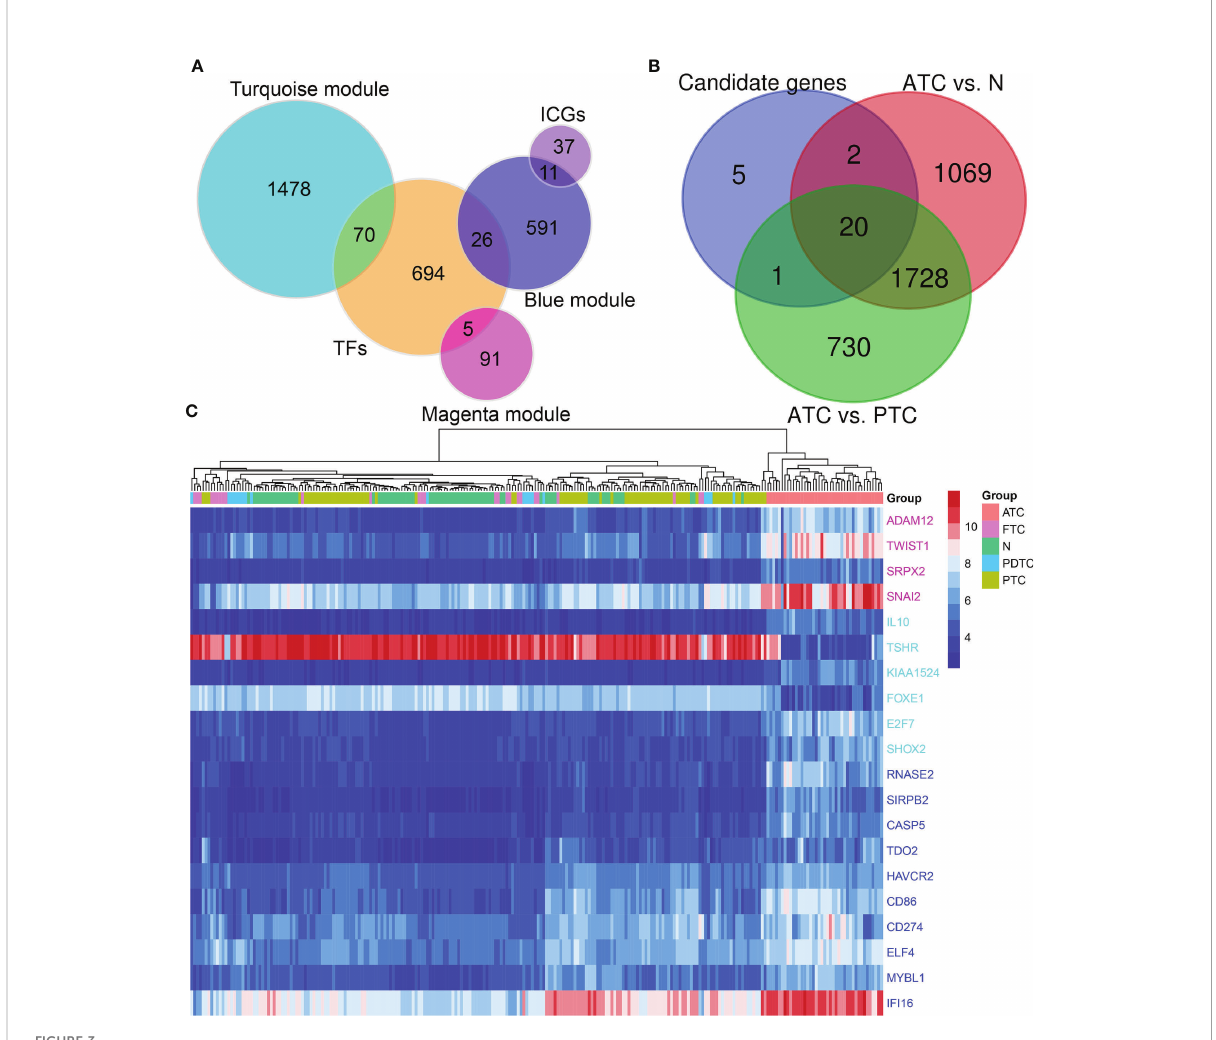
FIGURE 3 Potential key drivers screening from ATC-speci fi c modules. (A) TF and immune checkpoint gene detection. (B) Candidate genes are the top 3 genes and TFs with the highest aGS in turquoise, magenta, and blue modules, and ICGs in the blue module. Combined with differentially expressed genes in ATC compared to normal thyroid tissue samples and PTC to identify 20 key genes. (C) The hierarchical clustering heatmap shows expression levels of these 20 hub genes across all samples and gathers ATC samples together. TF, transcription factor; ICG, immune checkpoint gene; N, normal thyroid